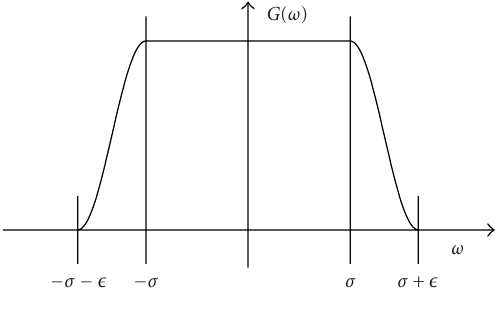
Figure 3.1. A (rough) sketch of G ( ω